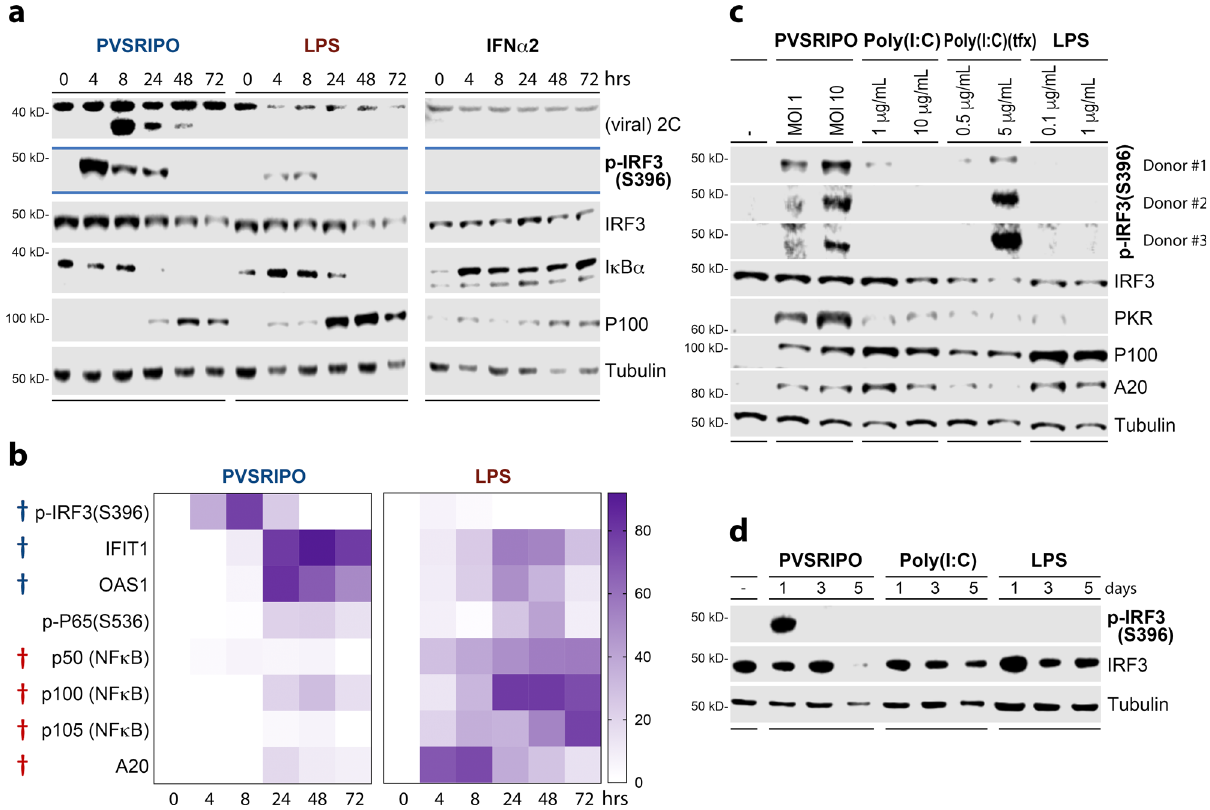
Fig. 5 Cytoplasmic dsRNA causes robust, sustained p-IRF3(S396) and ISG expression. a, b Immunoblot analysis of innate signaling in MDMs after treatment with PVSRIPO (MOI 10), LPS (100 ng/ml), or IFN α 2 (200 IU/ml) over time. Additional analyses from four donors, including those quantitated in ( b ), are presented in Supplementary Fig. 8. b %Max densitometry values for each protein/phospho-protein followed by subtraction of zero time point is shown. ( † ) Signi fi cant paired t test (two-tailed) comparing maximum value (across time course) induced by PVSRIPO (blue) vs LPS (red); IRF3-p (S396) p = 0.0001, IFIT1 p = 0.01, OAS1 p = 0.009, p50 p = 0.008, p 100 p = 0.001, p 105 p = 0.01, A20 p = 0.006. c Comparison of PVSRIPO, Poly(I:C), Poly(I:C)-tfx, and LPS treatment using respective low and middle doses presented in Fig. 4c by immunoblot for relevant proteins. Three donors were tested, p-IRF3(S396) blots are shown for all donors. d DCs were treated with mock, PVSRIPO, Poly(I:C) or LPS along a time course for immunoblot analysis as shown; n = 3